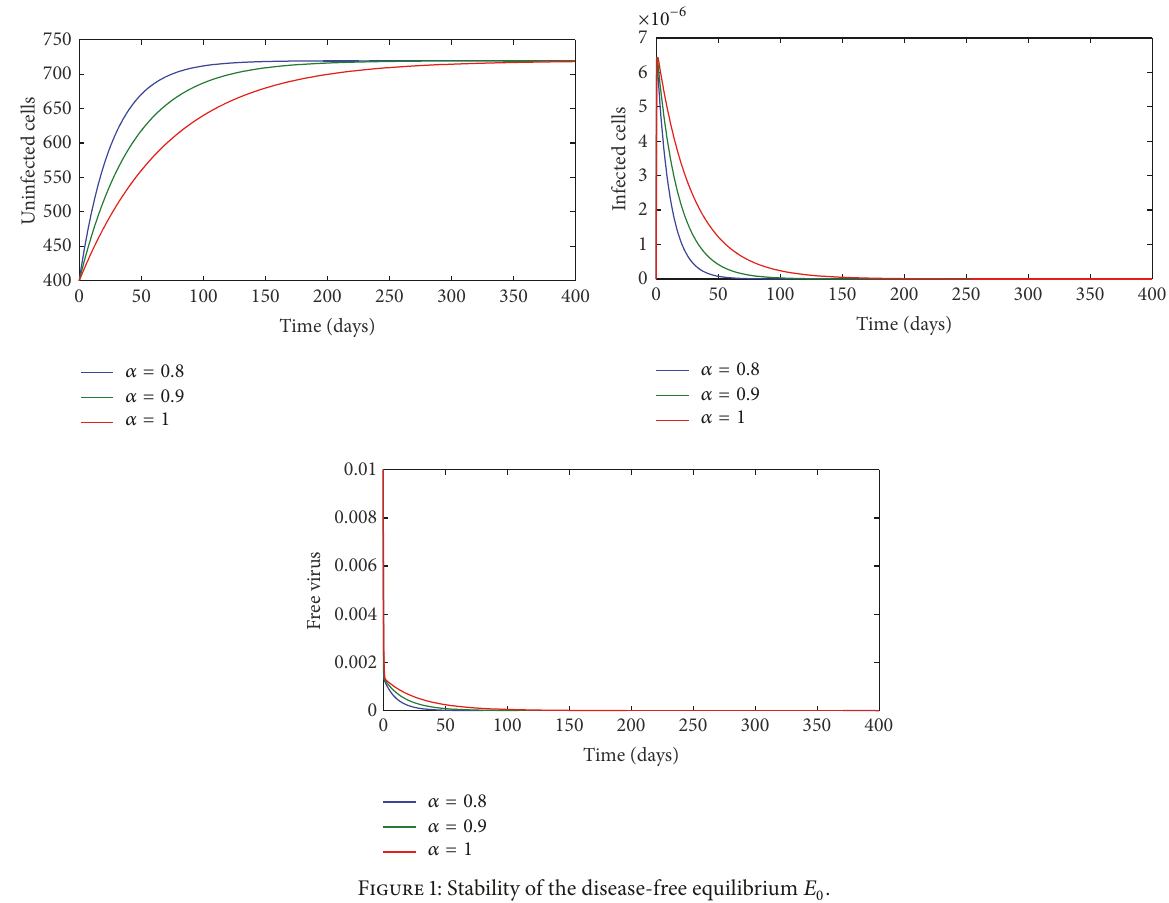
Figure 1: Stability of the disease-free equilibrium 𝐸 0